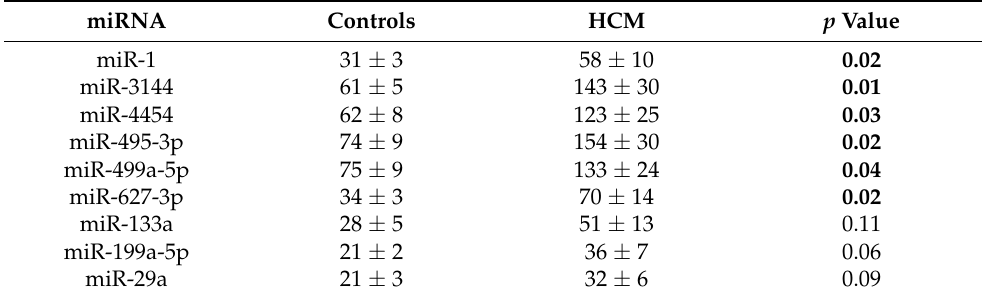
Table 2. Screening of circulating miRNAs in hypertrophic Cardiomyopathy (nCounter). The abso- lute fluorescence counts of circulating miRNAs are shown. Of the 800 miRNAs quantified, six miR- NAs exhibited higher plasma levels in patients with hypertrophic cardiomyopathy than in the healthy control individuals. miRNA Controls HCM